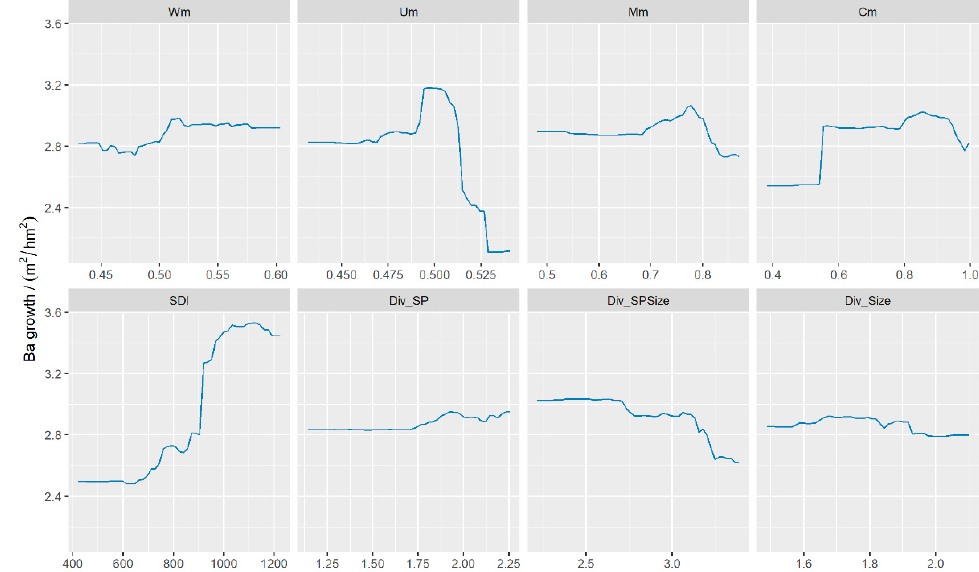
Figure 2. Basal area increment (BAI) of whole-stand simulations in relation to the most important predictor variables.